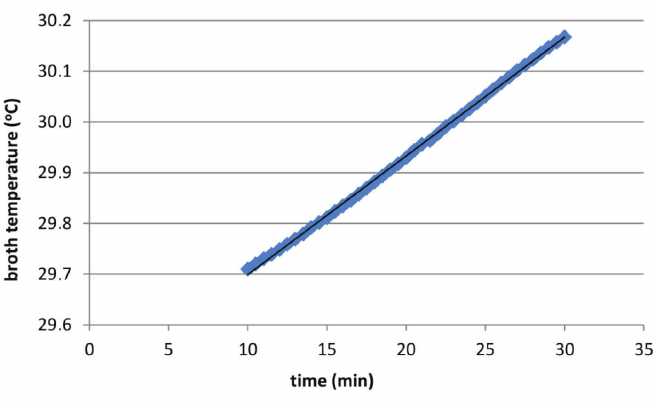
Fig. 2 – Example of the temperature-time profile measured in the laboratory calorimeter, from the slope of which the biopro- cess heat production rate can be